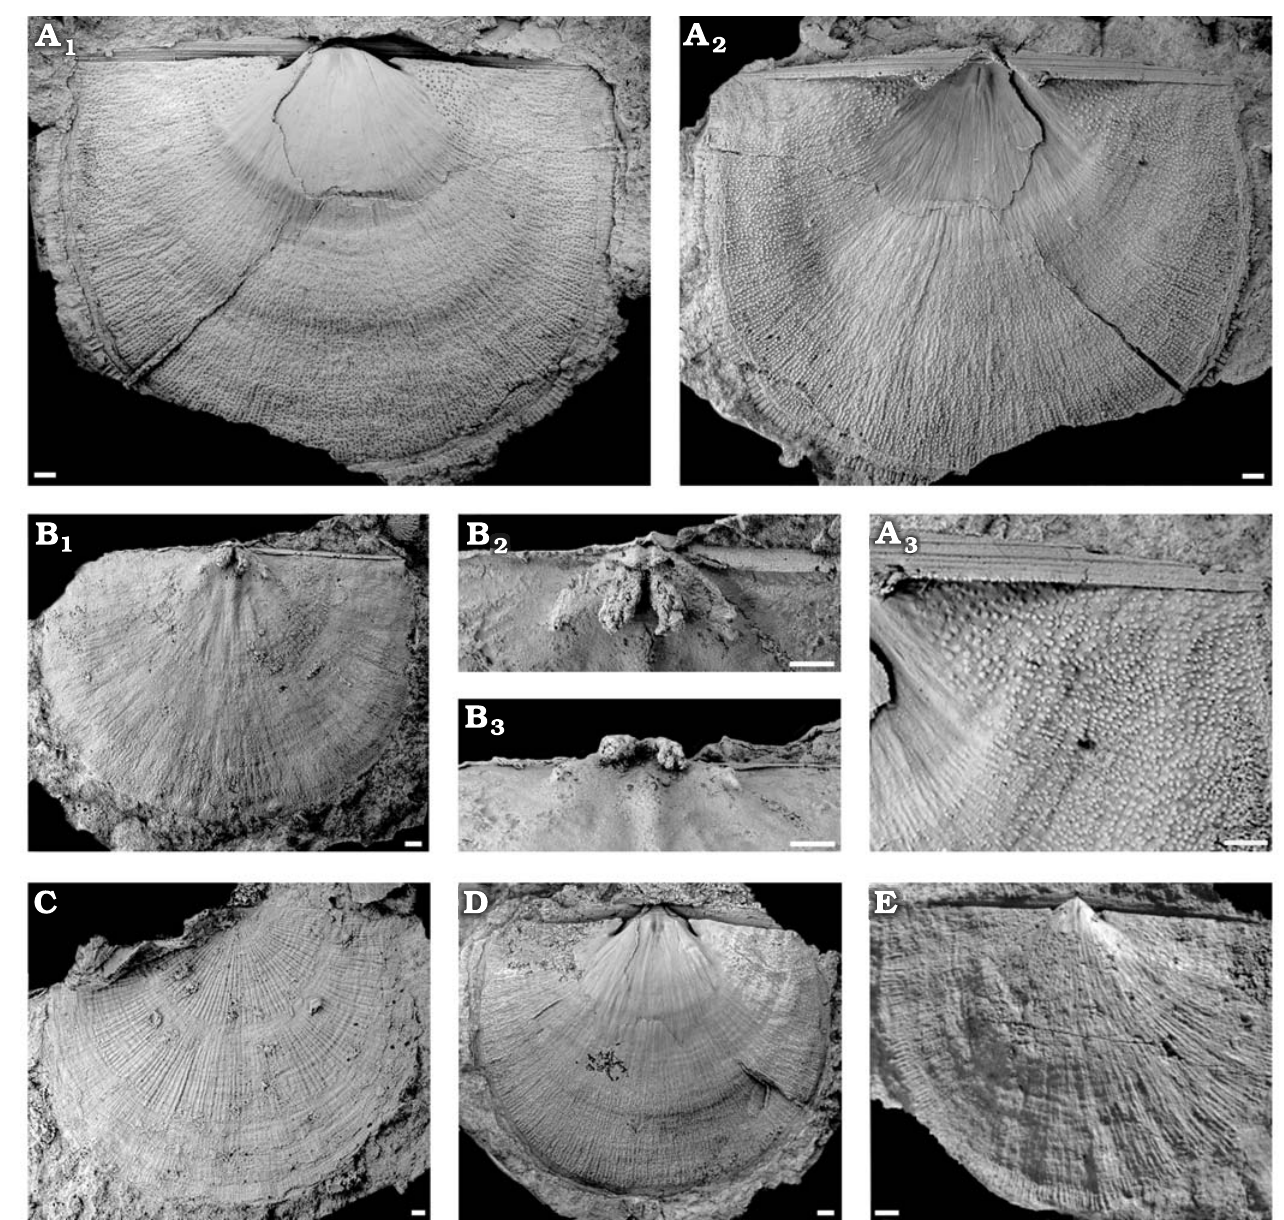
Fig. 14. Rafinesquinine brachiopod Rafinesquina ( Mesogeina ) loredensis sp. nov.; middle Katian (Ka2), Upper Ordovician; Porto de Santa Anna Formation, Portuguese Central Iberian Zone, Portugal. A . IGM-2919, holotype, internal mould (A 1 ), latex cast of interior (A 2 ), detail of pseudopunctae (A 3 ) of a ventral valve. B . IGM-2926, paratype, internal mould of dorsal valve (B 1 ), details of cardinalia in posteroventral (B 2 ) and anteroventral (B 3 ) views. C . IGM-2925, paratype, latex cast of exterior of dorsal valve. D . IGM-2927, paratype, internal mould of ventral valve. E . IGM-2923, paratype, internal mould of small ventral valve. Scale bars 2